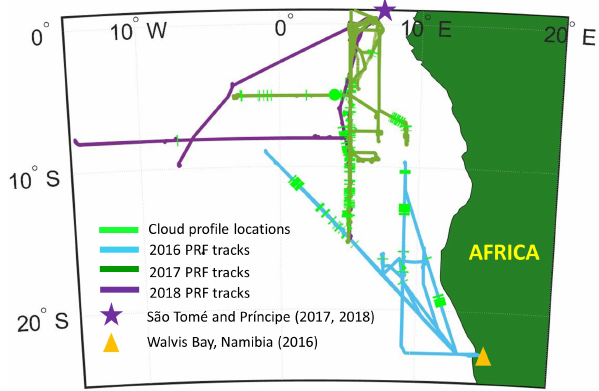
Figure 1. ORACLES flight tracks, bases of operations, and sam- pling locations for profiles with a MODIS retrieval co-located with in situ data for (cid:49)T less than